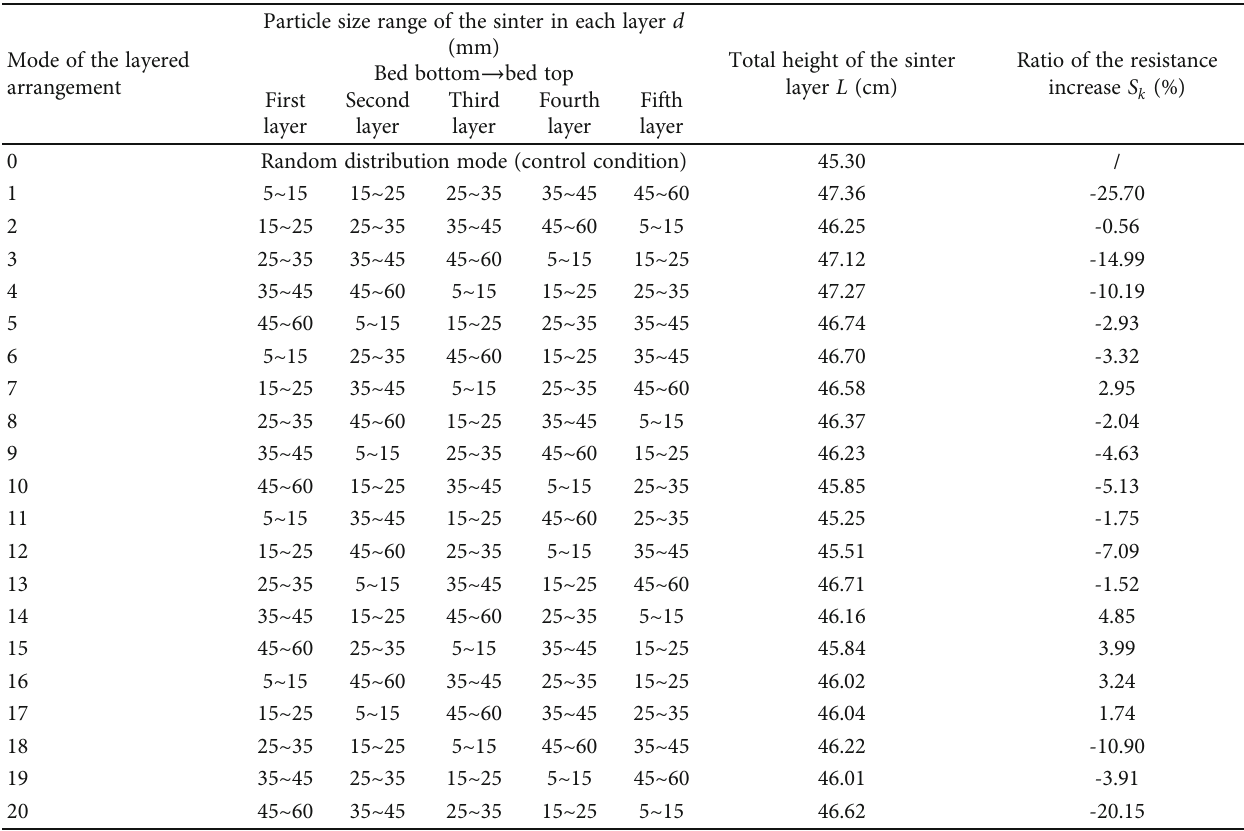
Table 4: All fi ve-layer arrangement modes for the sinter mixture with the equivalent particle diameter of 11.45 mm. Mode of the layered